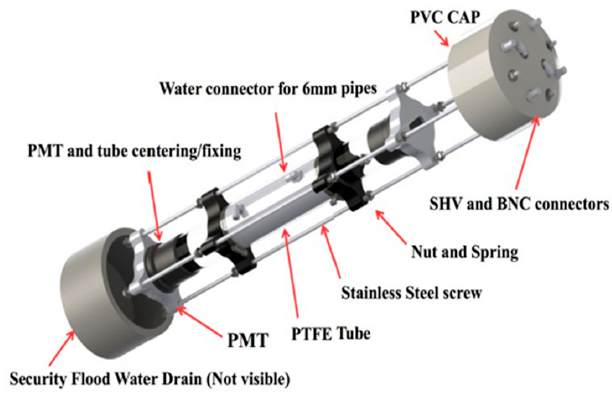
Figure 23. TRITIUM-1, AVEIRO detector prototype [90].